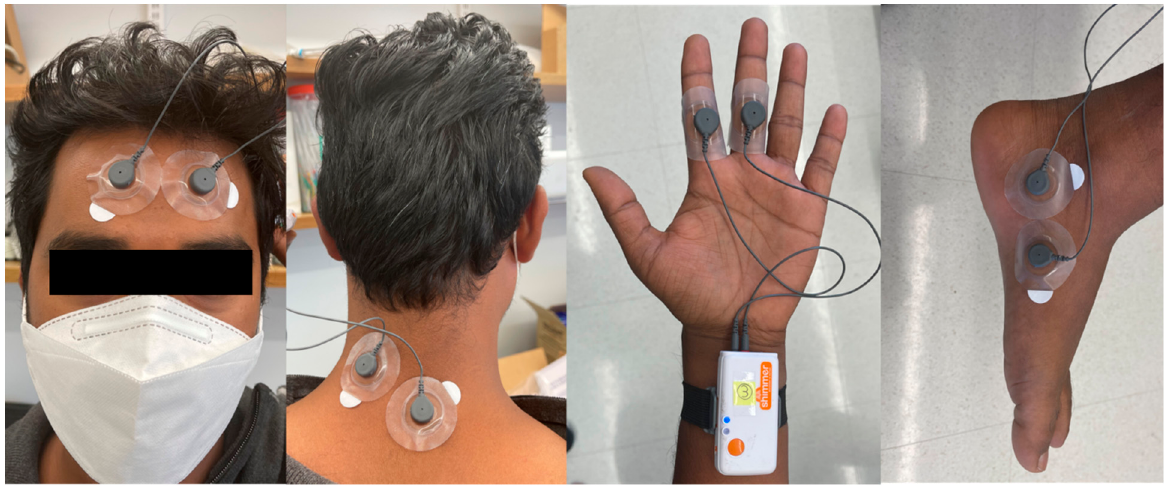
Figure 1. Different locations of electrode placement.